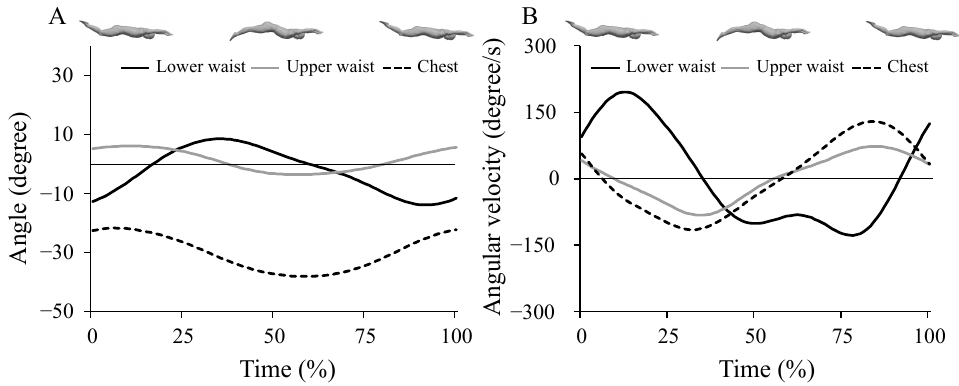
Figure 3. The typical time–history data of angles ( A ) and angular velocities ( B ) of the lower waist, up- per waist, and chest. The solid black line, solid gray line, and the broken black line represent the lower waist, upper waist, and chest, respectively. The positive and negative values represent the flexion and extension directions, respectively. 0%, 50%, and 100% represent the starting point of the downward kick, starting point of the upward kick, and finishing point of the upward kick,